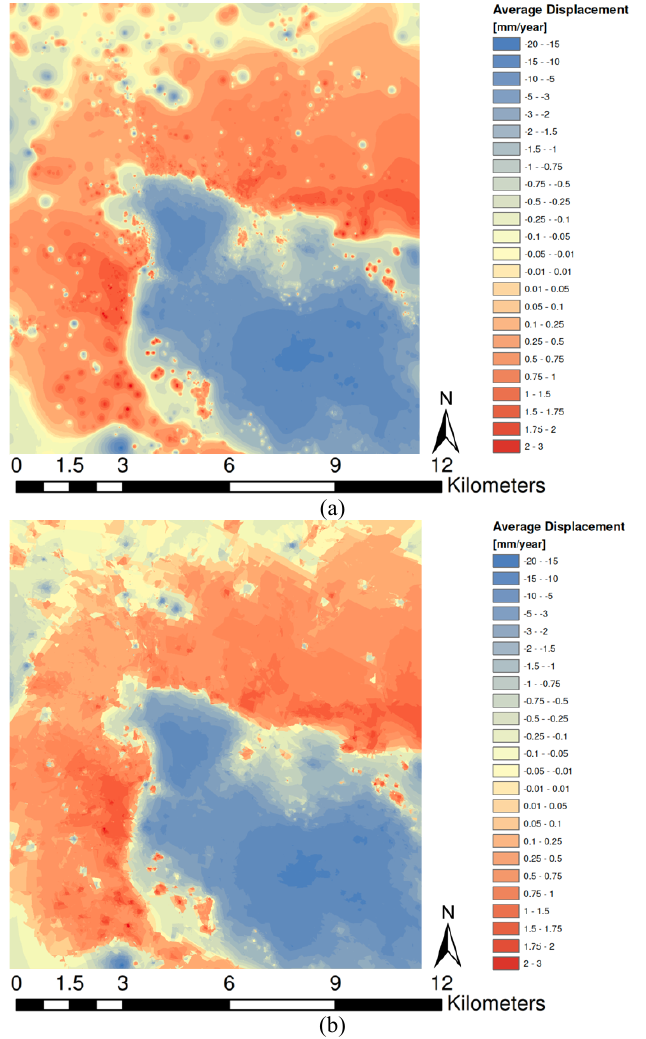
Figure 2. Surface Motion, (a) Observation, (b) Prediction